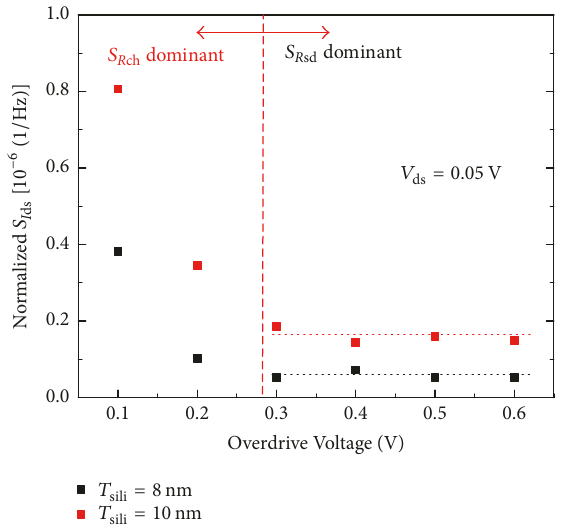
Figure 8: Normalized 𝑆 𝐼 𝑉 . ov